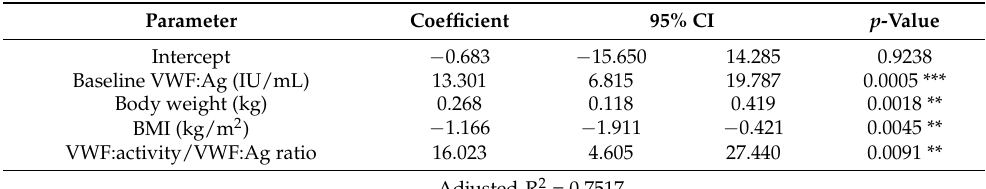
Table 7. Stepwise-backwards MVLR analysis of the half lives of O blood group patients, n =